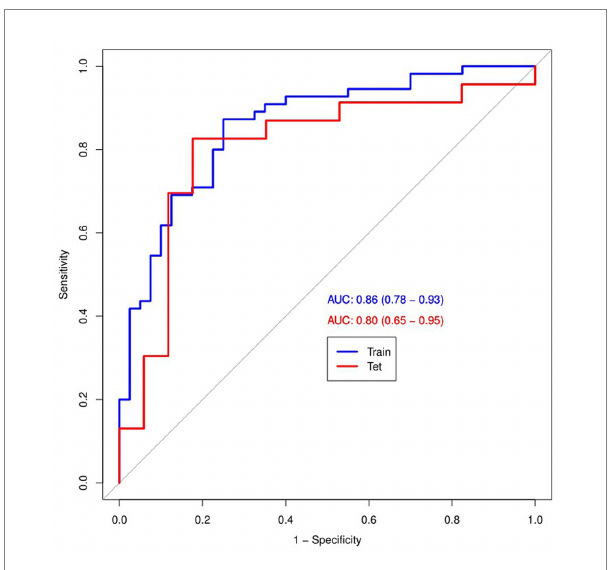
FIGURE 4 ROC curves (AUC) of the radiomics signature in the training and testing